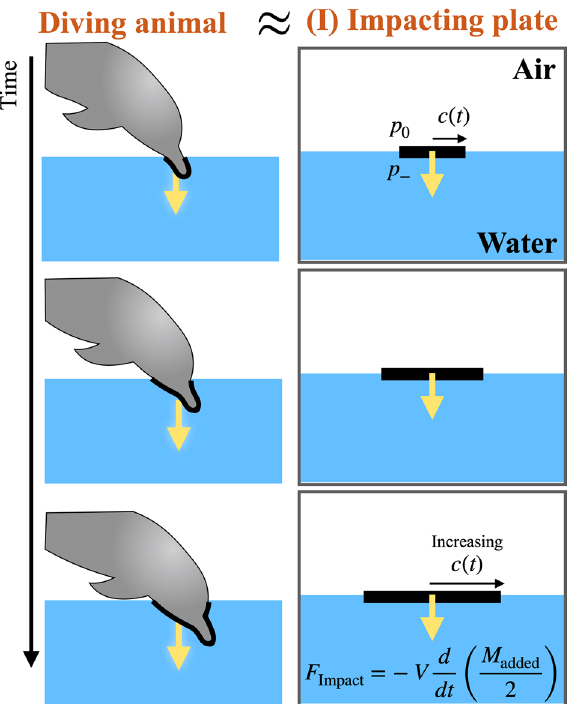
Figure 3. Schematic of a diving animal and a corresponding plate model with increasing its width. The resulting impact force depends on a time derivative of the added mass and